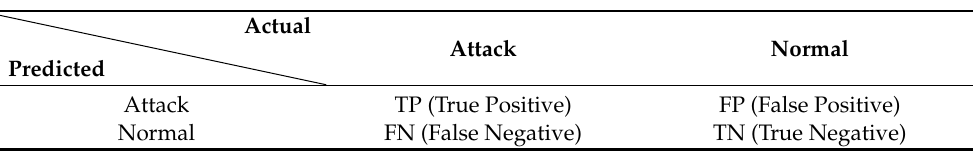
Table 2. Confusion matrix.